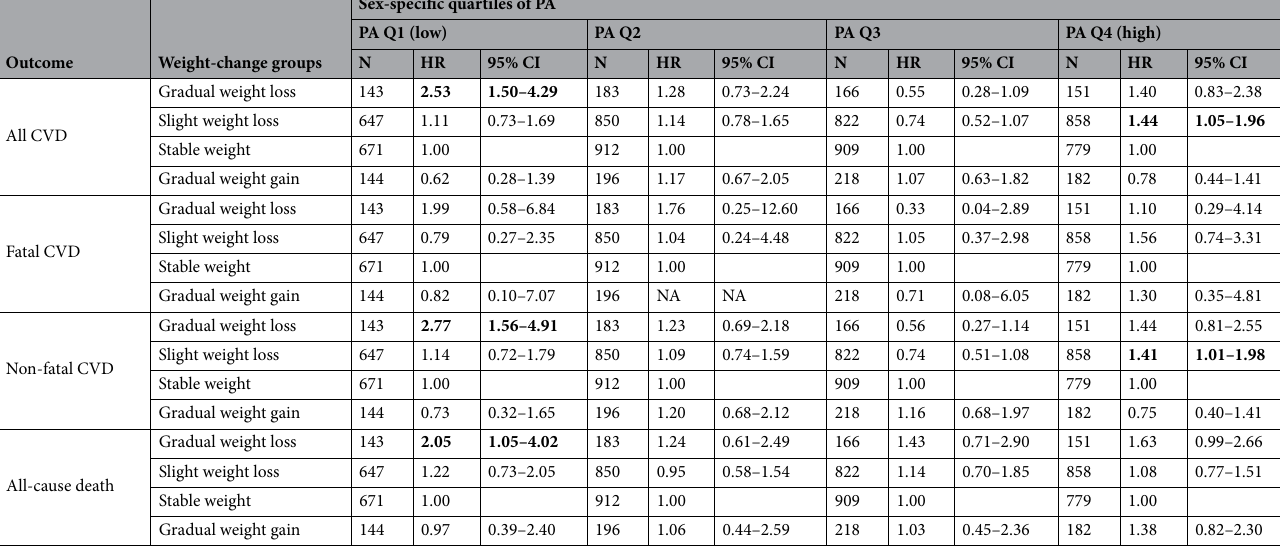
Table 3. Adjusted hazard ratio of incident CVD and all-cause mortality associated with weight trajectory by physical activity level. Significant values are in bold. Hazard ratios with 95% confidence intervals